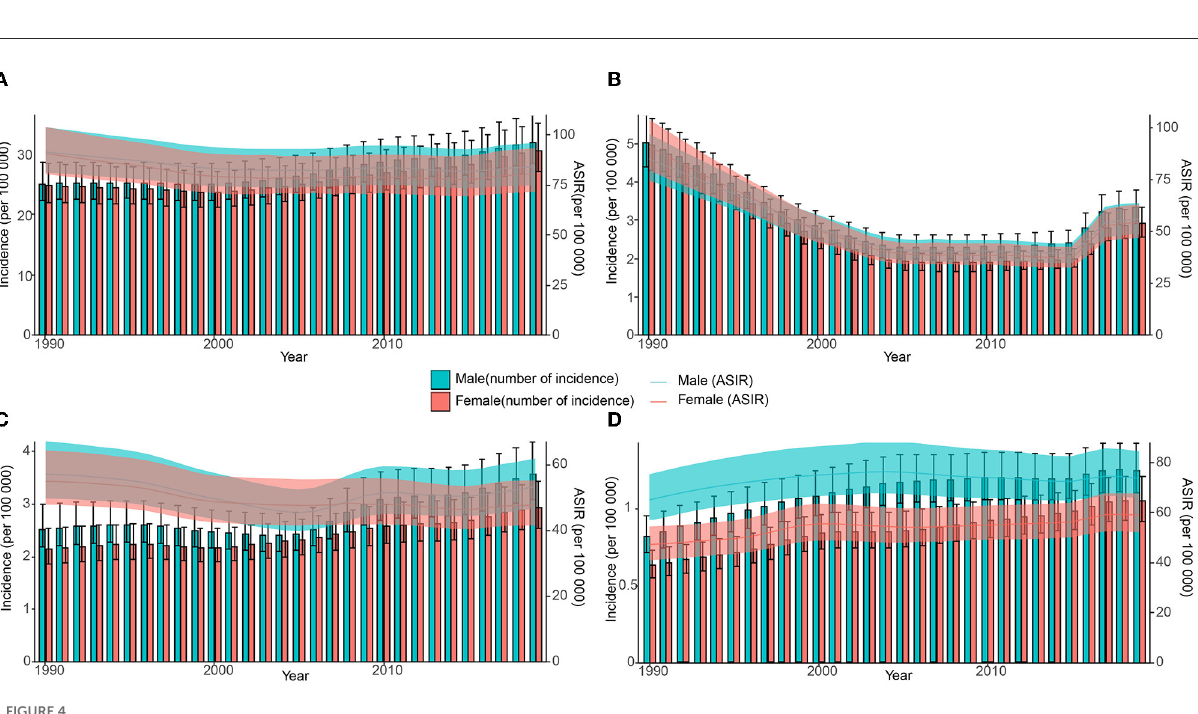
proportion of DALYs in the age group 0–29 in the United States is significantly lower, while the proportion of people over 60 years old is significantly higher than that in the world,